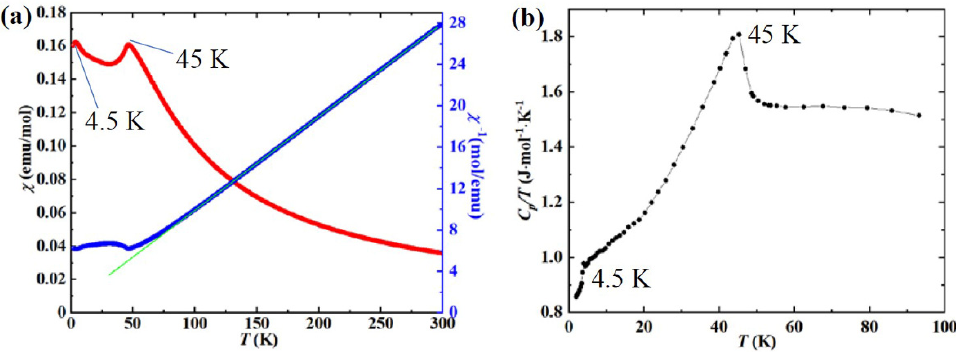
Figure 4. ( a ) The magnetic susceptibility χ ( T ) of Mn 3 O(SeO 3 ) 3 and its reciprocal. ( b ) The heat capacity of Mn 3 O(SeO 3 ) 3 . The green solid line indicates Curie–Weiss fitting.